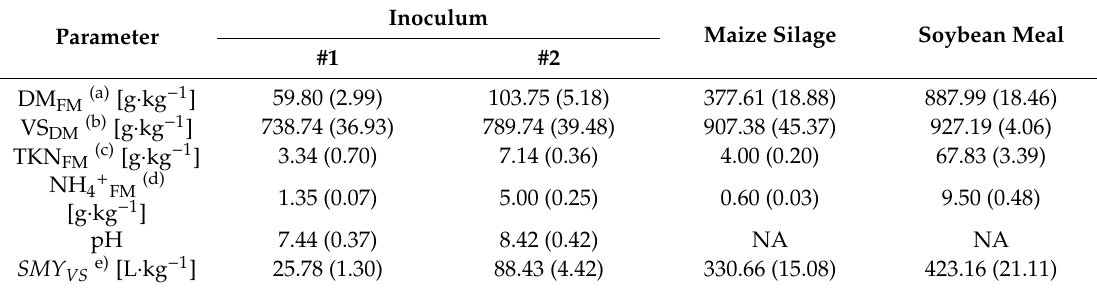
Table 2. Characteristics of the substrates. Gas volumes are given under standard temperature and pressure conditions (0 ◦ C, 101.325 kPa). Units are given in square brackets. Values are given as mean; the standard deviation is given in round